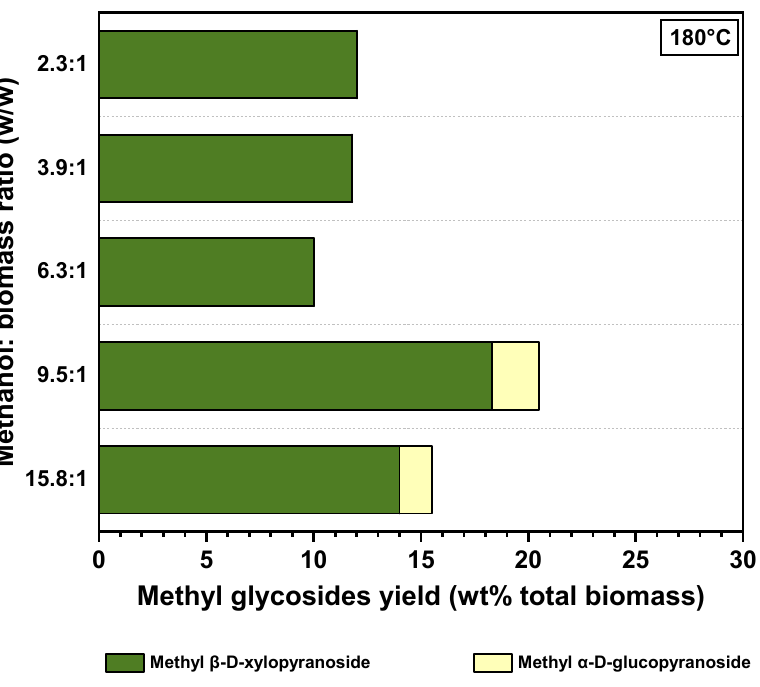
Figure 1. Yield of methylated glycosides in the lignin oil fraction derived from acid methanolysis of birchwood under different methanol/biomass ratios, at 180 °C and a reaction time of 2 h. The formation of methyl-D-glycosides under these conditions is not well understood.